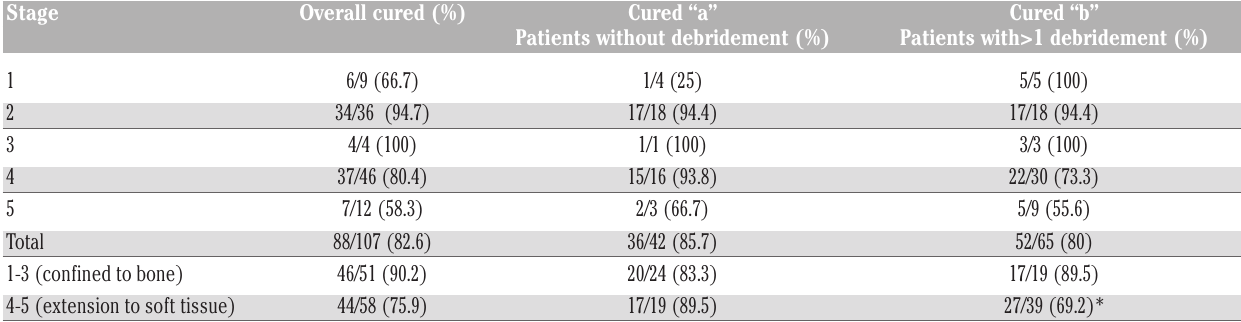
Table 5. Hematogenous stage and